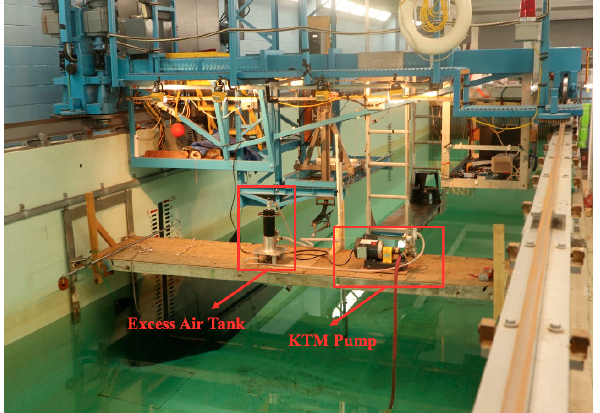
Figure 5. The setup of the Nikuni KTM pump in the tow tank.